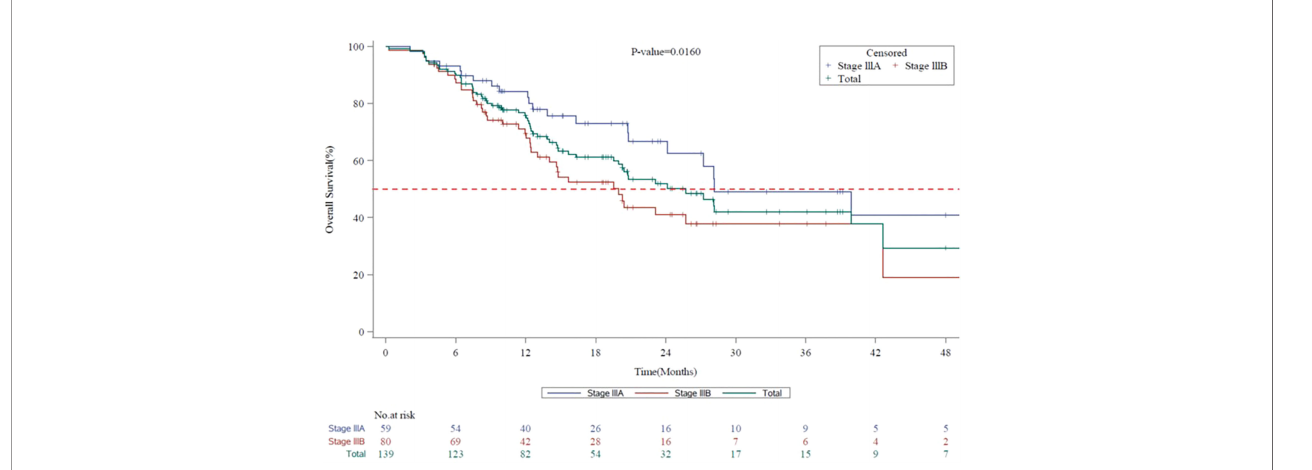
FIGURE 3 | Kaplan-Meier Survival Curves for Overall Survival by Disease Stage (7 th Edition AJCC) in Vietnam. AJCC, American Joint Committee on Cancer; CI, con fi dence interval; mOS, median overall survival. Kaplan-Meier survival curves for overall survival for all stage III NSCLC patients are shown in green, whereas stage IIIA and stage IIIB patients are shown in blue or red, respectively. mOS for the entire Vietnam cohort, 25.7 months (95% CI, 19.98 to 42.61). mOS for stage IIIA, 28.2 months (95% CI, 24.15 to not-calculable [NC]). mOS for stage IIIB, 20.0 months (95% CI, 13.01 to